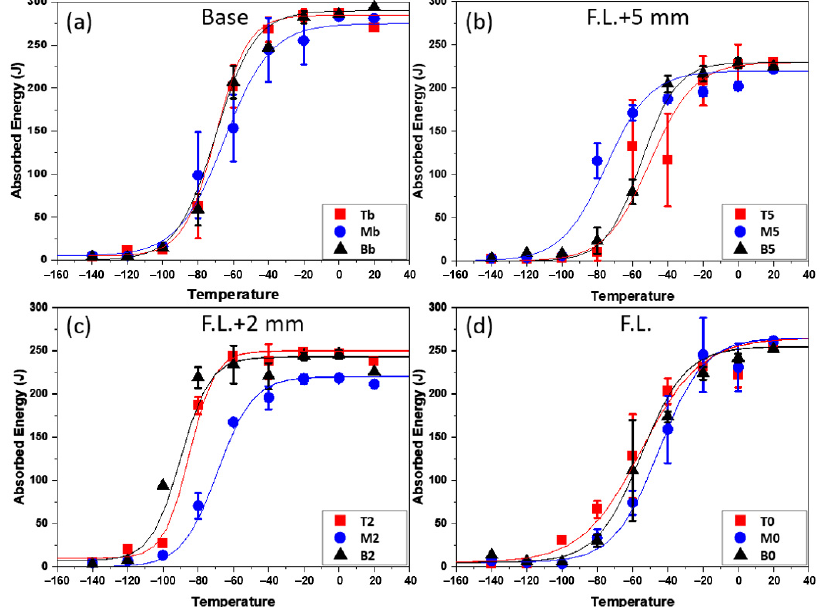
Figure 7. Charpy impact energy of the TMCP Base metal and heat-affected zone: ( a ) base metal, ( b ) fusion line +5 mm, ( c ) fusion line +2 mm ( d ) fusion line.